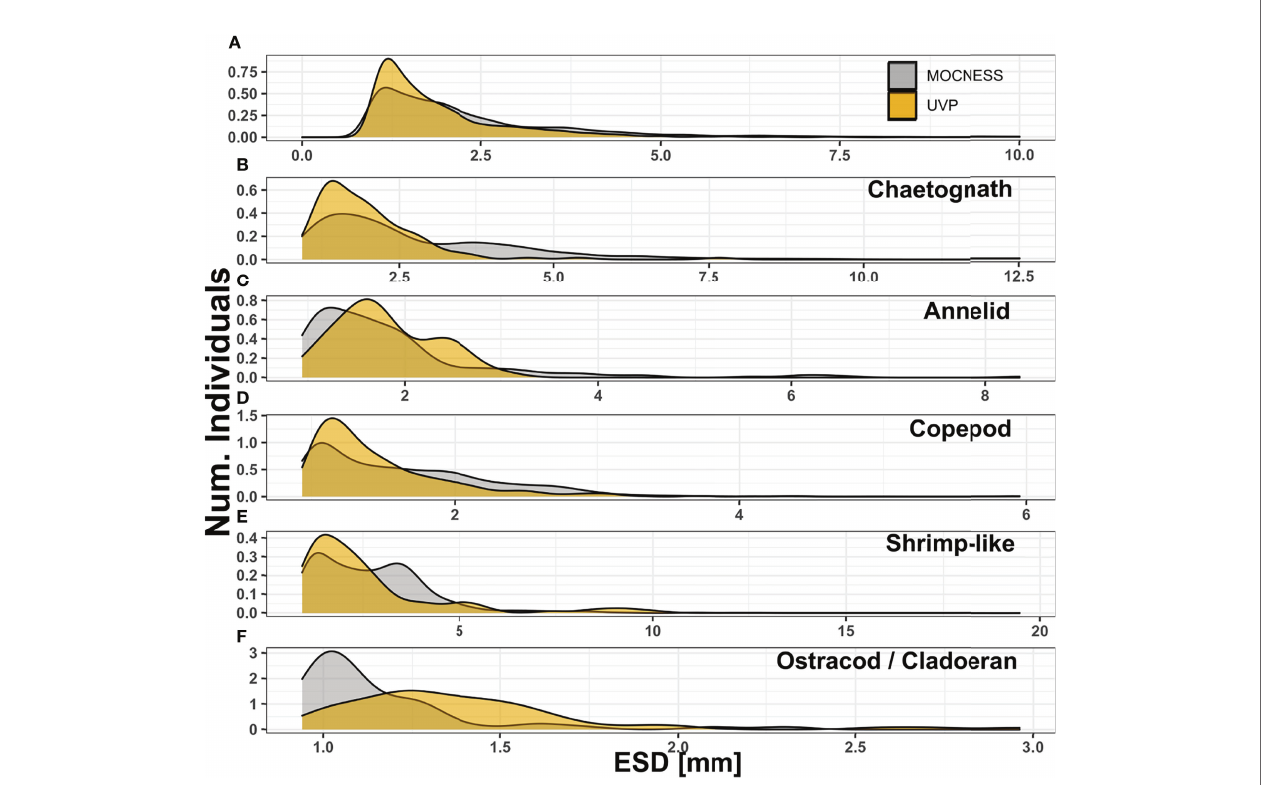
FIGURE 2 | Size distribution compared between MOCNESS-collected plankton (excluding those smaller than 934 m m) and UVP-imaged plankton for (A) All living organisms, (B) chaetognaths, (C) annelids, (D) copepods, (E) shrimp-like crustaceans, (F) ostracods/cladocerans. For all living organisms, those larger than 10mm ESD were excluded to allow for visualization. Notes that between each panel y and x axis